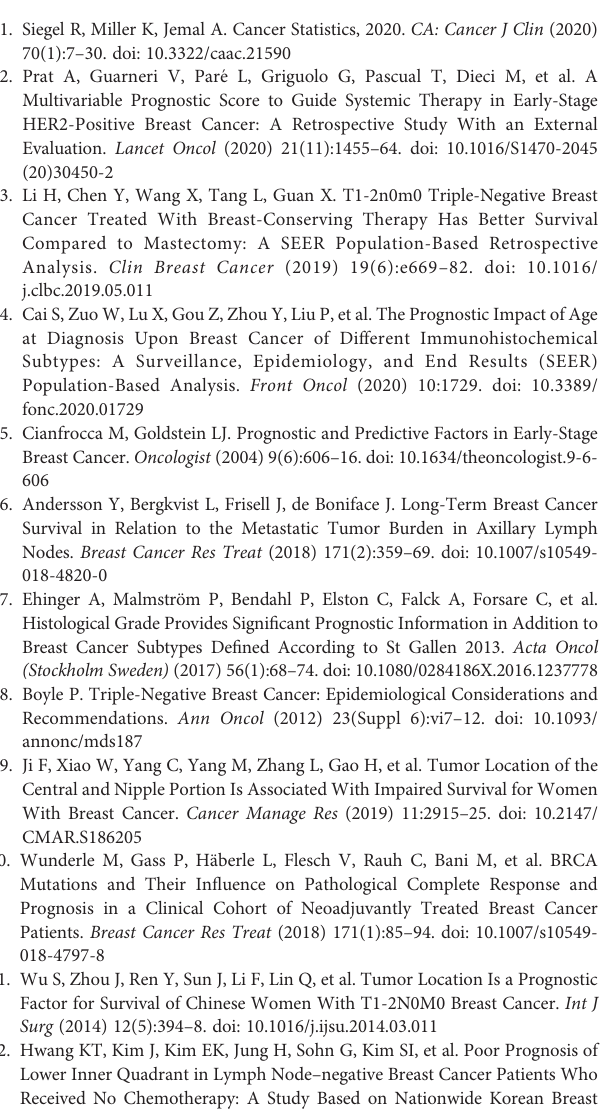
cancer speci fi c survival; BCT, breast-conserving therapy; A/PI, Asian/Paci fi c Islander; AI/AN, American Indian/Alaskan native. Supplementary Figure 4 | Kaplan-Meier Curves for OS by Treatment Type for All Patients, Strati fi ed by Histological Grade: (A) Grade I. (B) Grade II. (C) Grade III. (D) Grade IV. BCSS, breast cancer speci fi c survival; BCT, breast-conserving therapy. Supplementary Figure 5 | Kaplan-Meier Curves for OS by Treatment Type for All Patients, Strati fi ed by AJCC stage: (A) AJCC stage I. (B) AJCC stage II. (C) AJCC stage III. (D) AJCC stage IV. BCSS, breast cancer speci fi c survival; BCT, breast- conserving therapy. Supplementary Figure 6 | Kaplan-Meier Curves for OS by Treatment Type for All Patients, Strati fi ed by Molecular Subtype: (A) Luminal A. (B) Luminal B. (C) HER2 enriched. (D) Triple-negative. BCSS, breast cancer speci fi c survival; BCT, breast- conserving